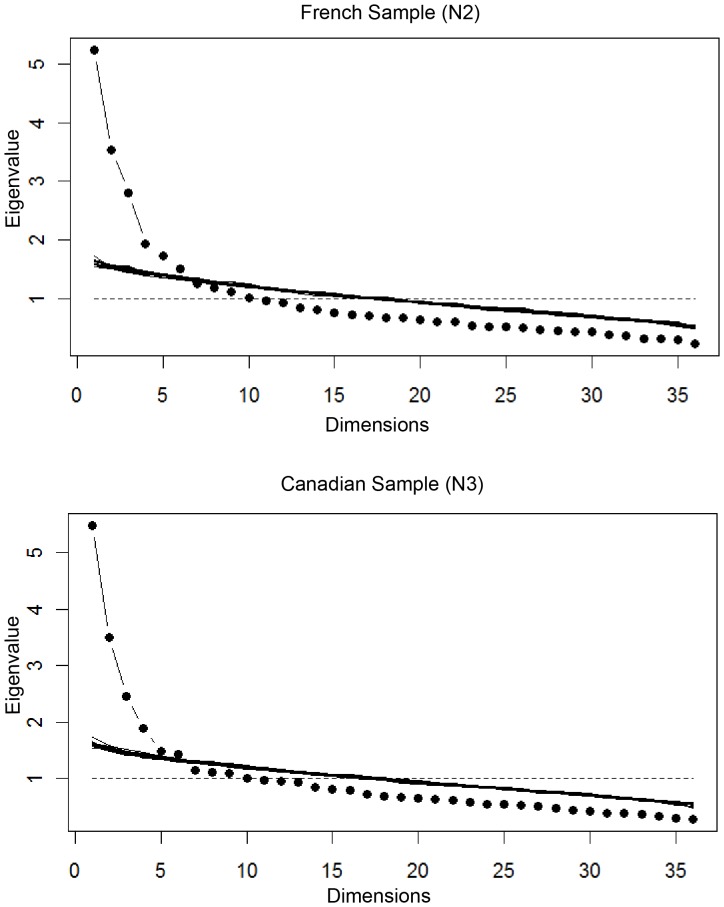
Title: Number of dimensions in the ANPS-S in the French Sample (N2) & the Canadian Sample (N3).Legend: Representation of eigenvalues with simulated data sets: six dimensions emerge (above the simulation lines) for the Affective Neuroscience Personality Scales Short Version.